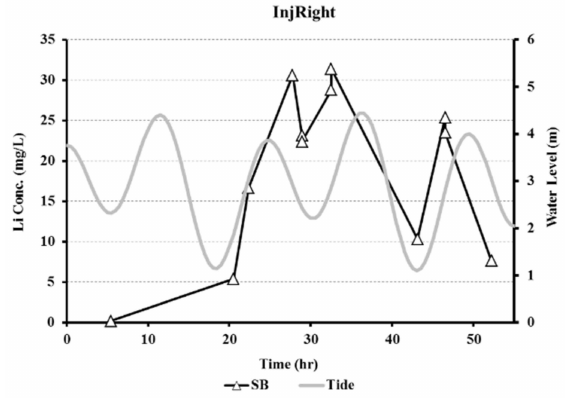
Figure 7. Variation of the concentration at various vertical locations at InjRight, which was 1.5 m right (looking landward) of the injection well. Only one SB was placed at this